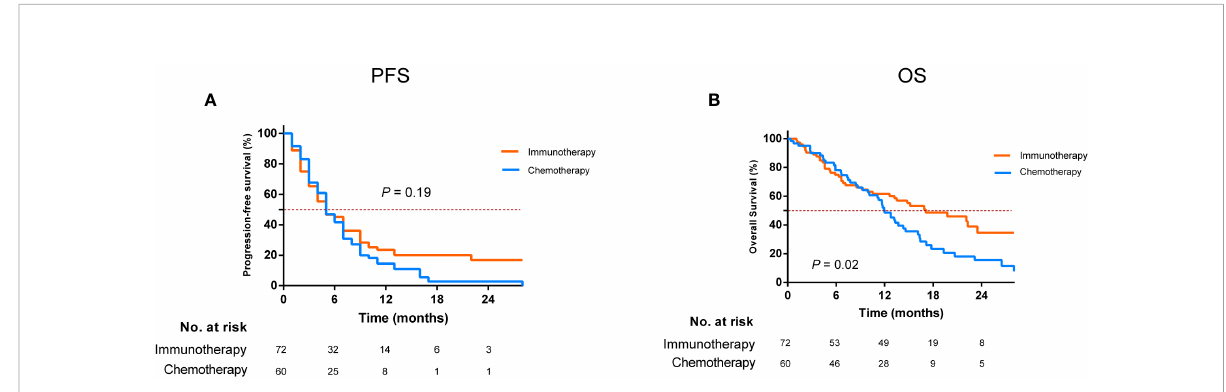
FIGURE 1 Comparison of progression-free survival (A) and overall survival (B) for patients who developed EGFR-TKI resistance treated with immunotherapy and chemotherapy alone. EGFR, epidermal growth factor receptor; TKI, tyrosine kinase